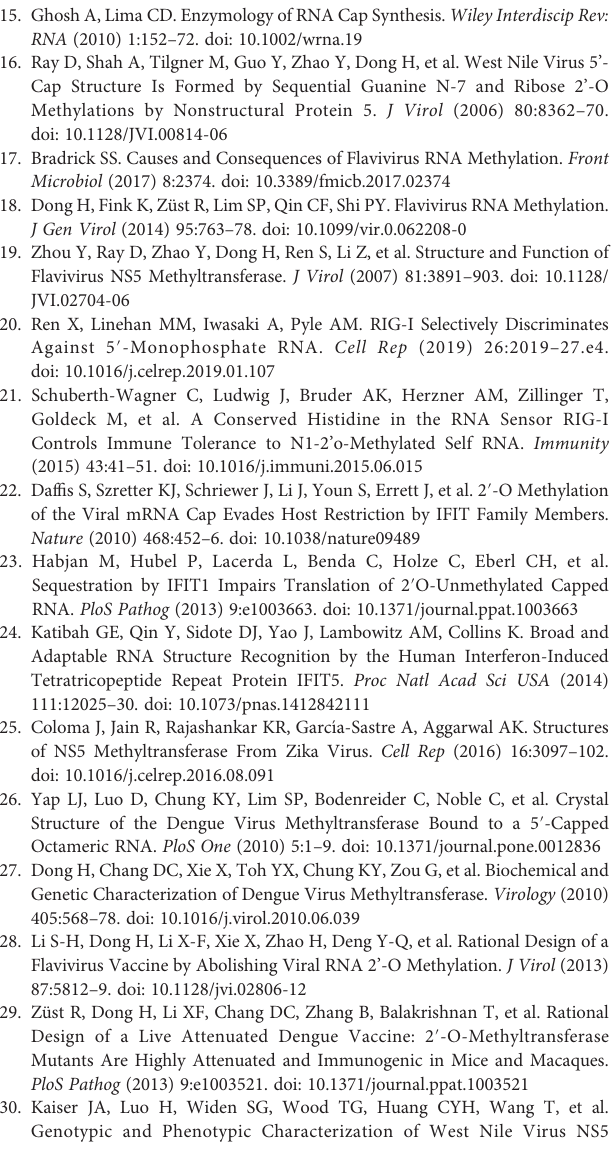
Supplementary Figure 1 | Stability analysis of the transfection of translation template RNAs. Cells transfected with RNA reporters were lysed at 4 h post- transfection, and total RNA was extracted. Absolute qPCR that detected RLuc gene were used to measure the RNA copy numbers. Each of these was conducted with three parallel replicates. Bars show means ± SDs (one-way